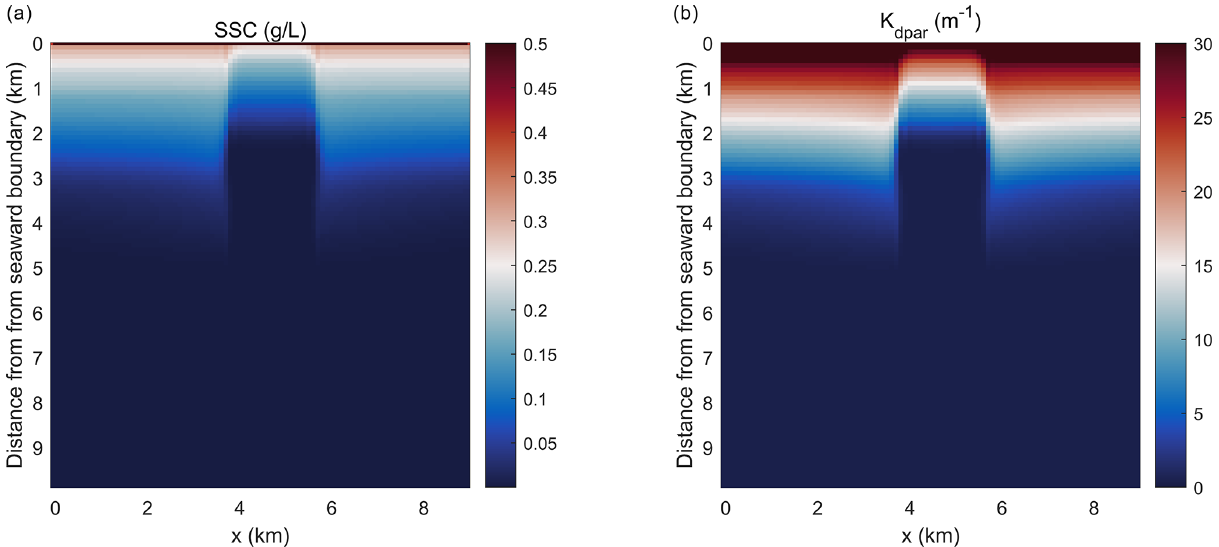
Figure 4. Planform view of (a) depth-integrated suspended sediment concentration (SSC) and (b) light attenuation averaged over the last day of the simulation in the idealized domain.